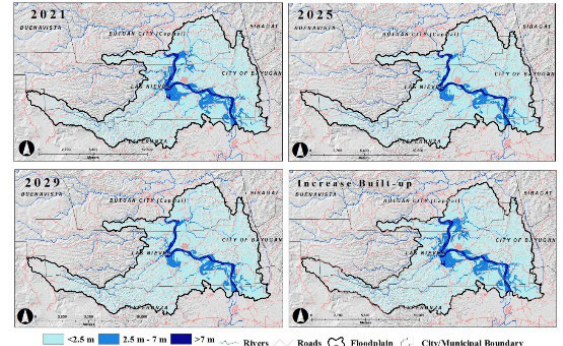
Figure 9. Flood depth maps with a 10-year rainfall return